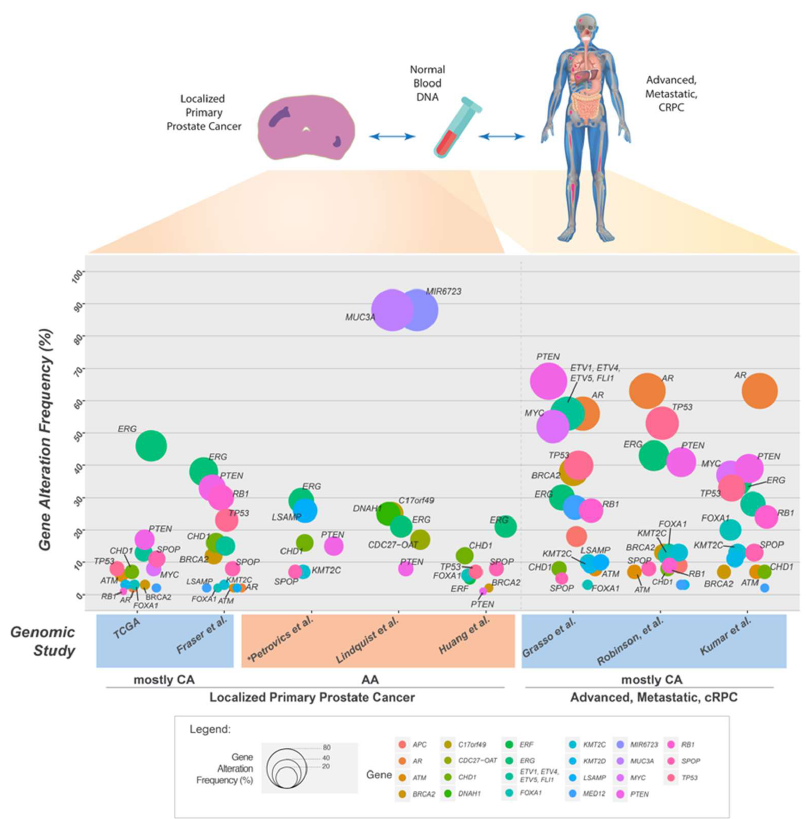
Figure 4. Frequency of somatic gene alteration events reported in selected genomic studies of localized primary prostate cancer and in advanced, metastatic, and/or castrate resistant prostate cancer. Size of circle is proportional to the frequency of gene alteration events (point mutations, deletions, amplifications or gene fusions). * Only gene alteration events in African American cases are shown.